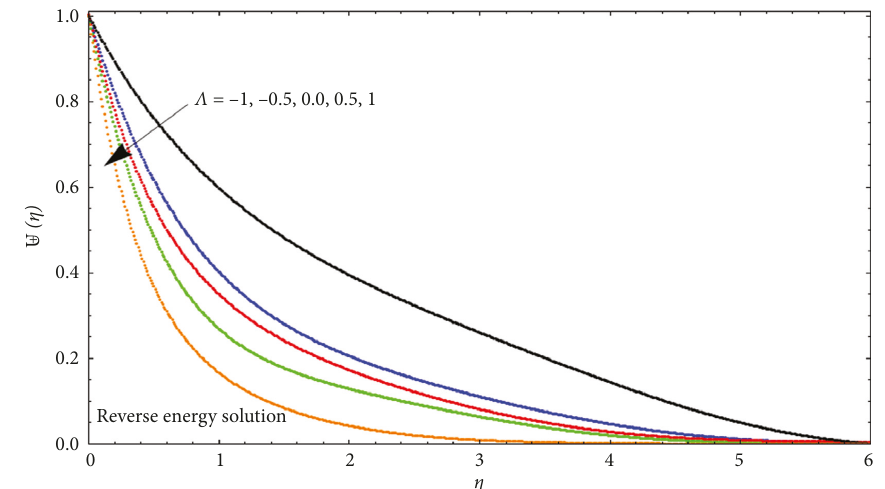
Figure 10: Dissimilarity of ⊎ ( η ) being some different values of Λ and Pr � 1 for only